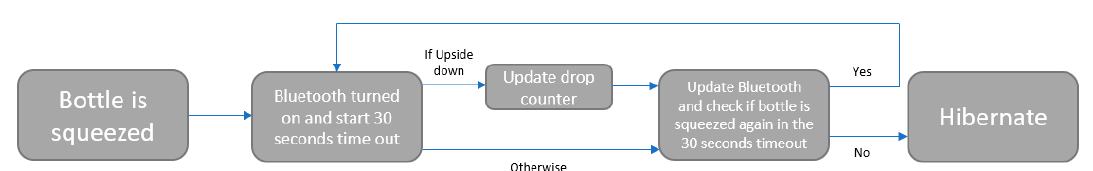
Figure 2. Scheme depicting normal behavior of the eyedrop bottle system. When upside-down bottle is squeezed, the system broadcast such the time stamp information of when the bottle was